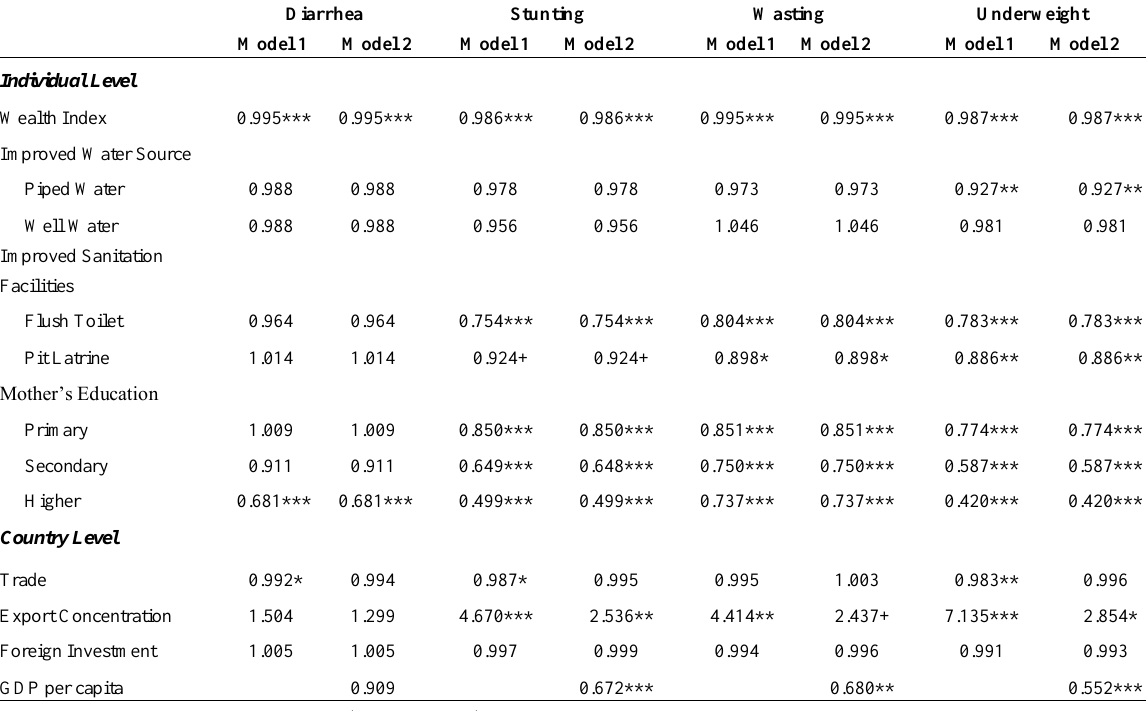
Table 2. HGLM Logit Models of Child Health on Fundamental Cause and Political Economy (Odds Ratios